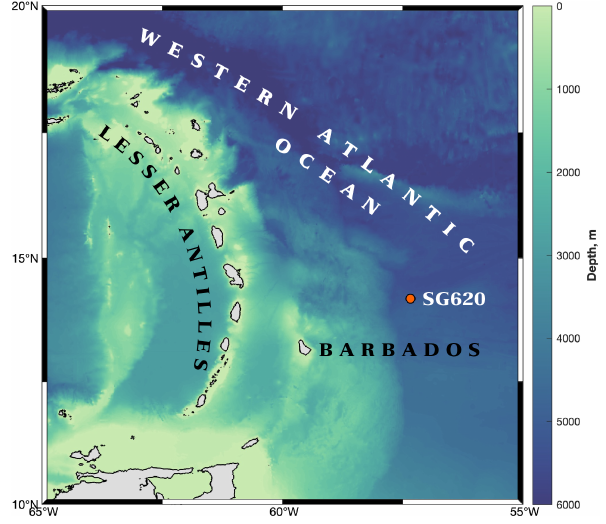
Figure 1. Bathymetry (m) of the western tropical Atlantic and the eastern Caribbean Sea in the region of the Lesser Antilles. The lo- cation of SG620, north-east of Barbados, is marked by the orange circle. Land is shaded